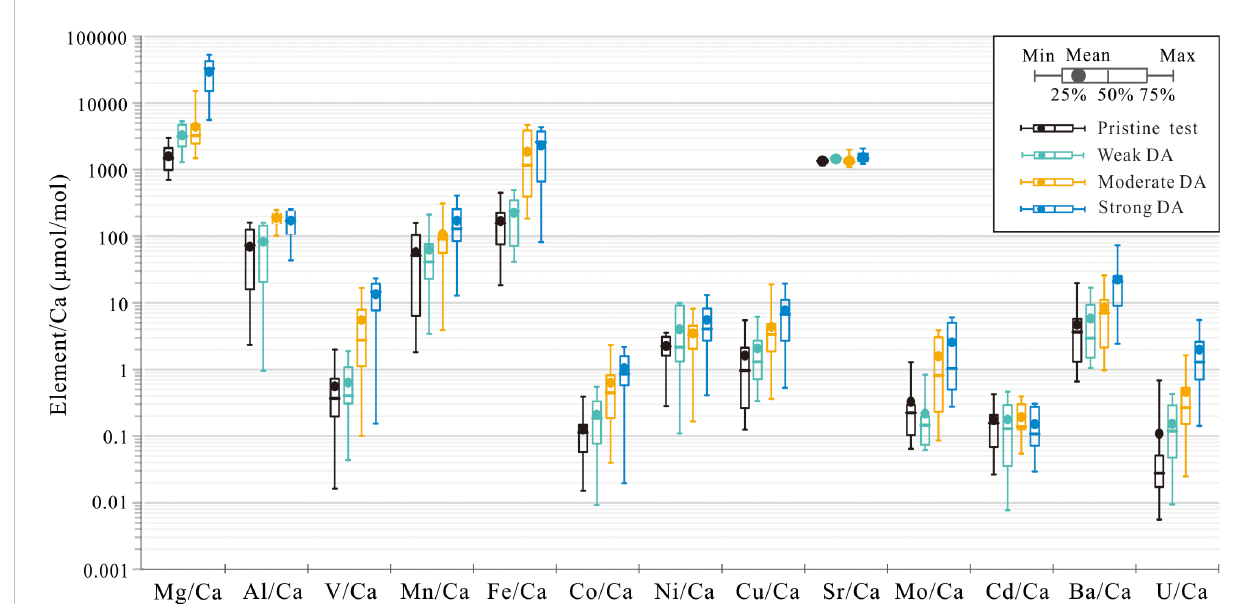
FIGURE 5 Boxplots of Element/Ca of foraminiferal specimens measured by LA-ICP-MS and tabulated according to degree of diagenetic alteration: pristine (black), weakly altered (green), moderately altered (orange), and strongly altered